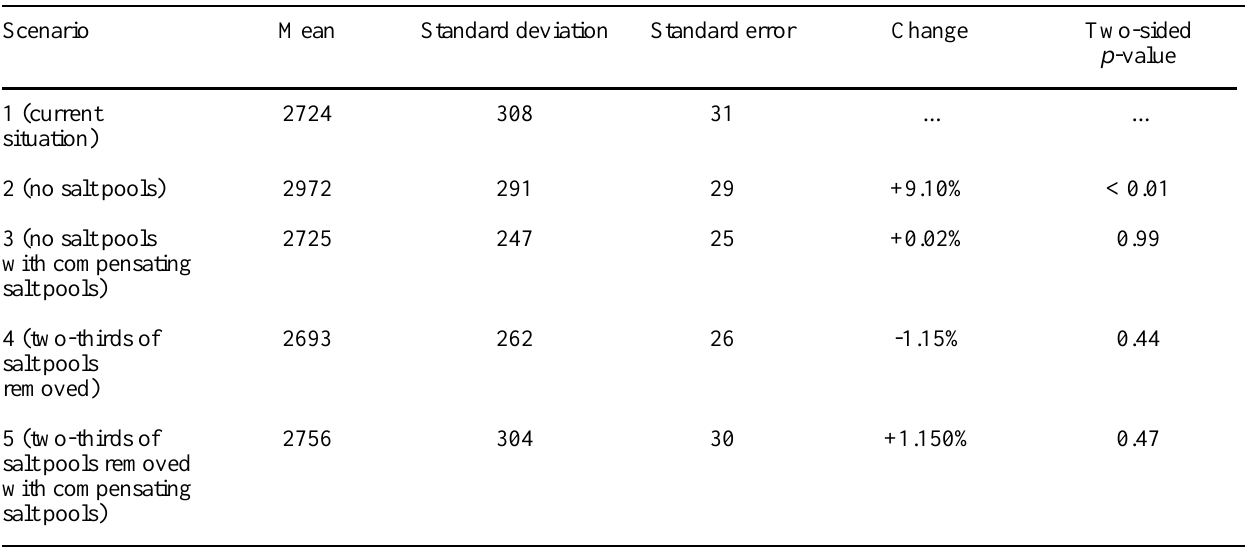
Table 6 . Total distance traveled by model moose while traveling during the summer period according to five different modeling scenarios. Modeling scenarios differed from each other with respect to the degree of salt pool removal and the creation of compensatory salt pools. We conducted 100 runs per scenario. The “Change” value means change compared to the current